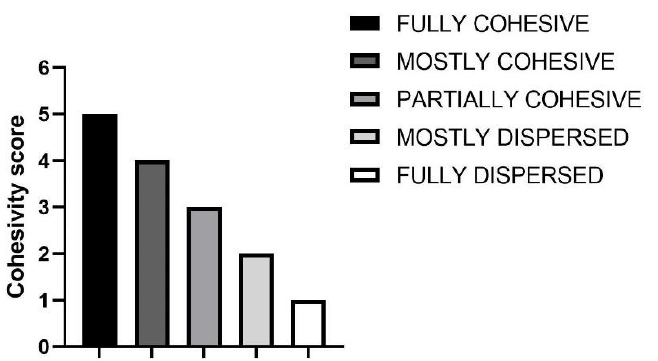
Figure 4. Reproduced Gavard–Sundaram Cohesivity Scale, used as a reference for the data-collected interpretations [2]. Graph obtained with GraphPad Prism 9.0.2 (GraphPad Software, Inc., San Diego, CA, USA).